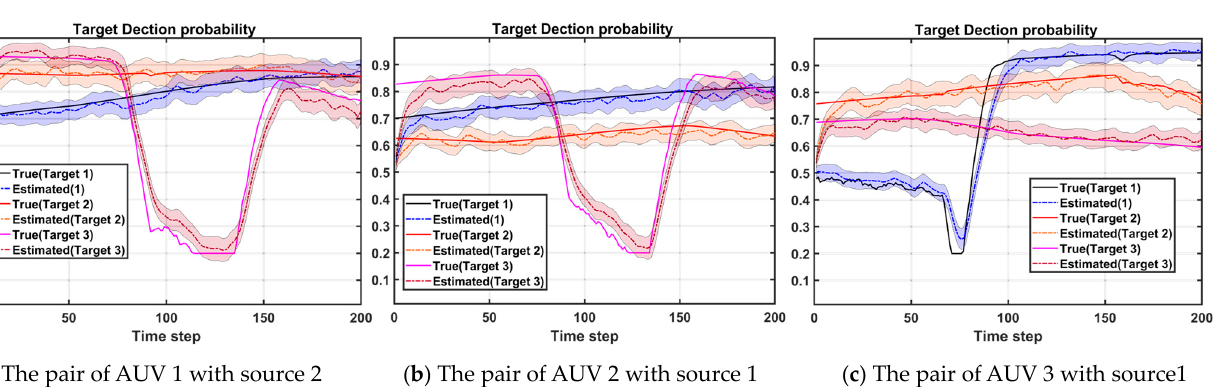
Figure 7. MC average results: True and estimated target detection probabilities of di ff erent S/R pairs. Shaded areas represent standard deviations of estimates.